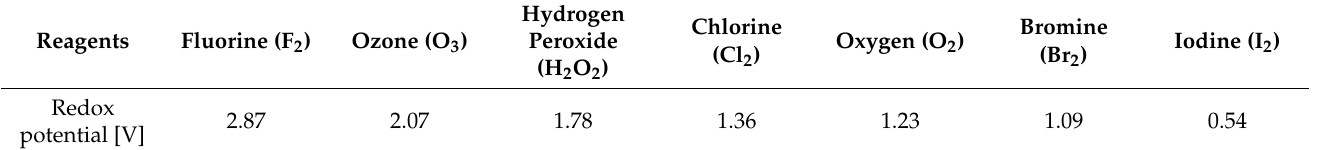
Table 1. Comparison of oxidizing properties of selected reagents adapted from [26].